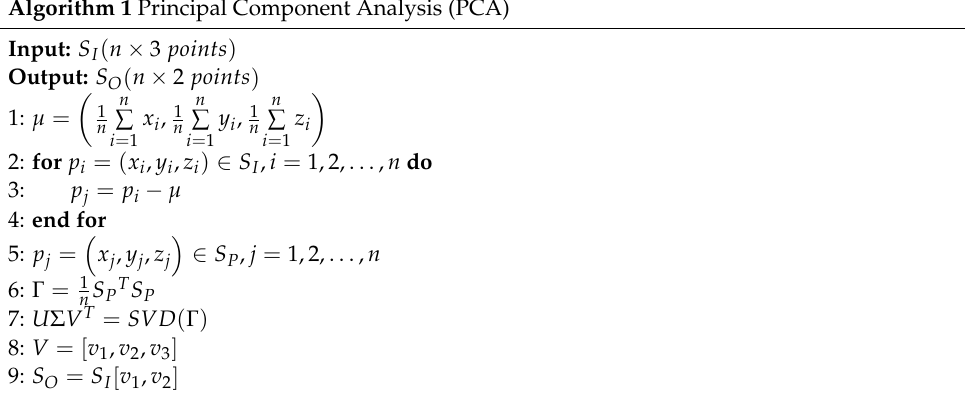
Figure 1. The whole process of the method. The raw data are input to the PCA-based Algorithm 1, and the data are divided into three parts: ceiling, wall, and ground. Then, the three-dimensional wall is transformed into an image by Algorithm 2. Next, we use slope-based Algorithm 3 to find lines in the image. Finally, the three-dimensional interior structure is restored from lines by Algorithm 4. Algorithm 1 Principal Component Analysis